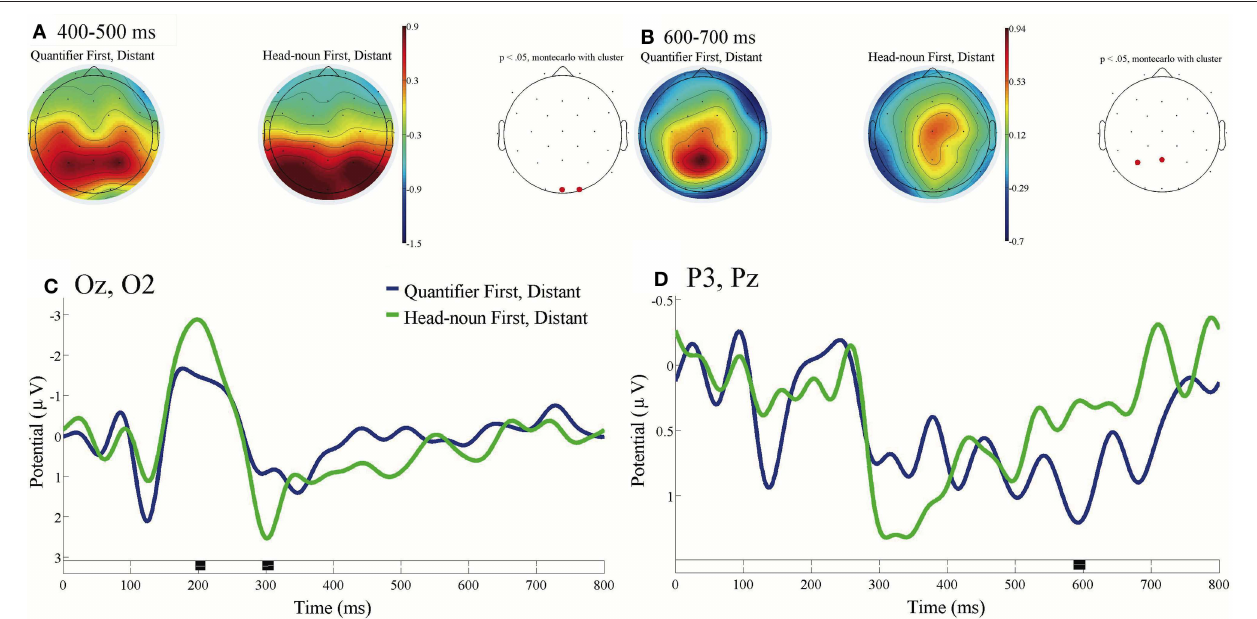
FIGURE 4 | ERPs time-locked to the onsets of the fifth phrases of Distant in Quantifier First and Head-noun First in (A–D) with the baseline from 0 to 100 ms. (A) Mean topographies of the ERPs from 400 to 500 ms and (B) those from 600 to 700 ms for Quantifier First (left) and Head-noun First (right) conditions; the electrode sites at which significant differences were found by using the cluster-based permutation test ( p < 0.05) are depicted in red. (C) Mean ERPs of the two conditions at the occipital electrodes (Oz and O2) and (D) mean ERPs of the two conditions at the (left) parietal electrodes (P3 and Pz). Negativity is plotted upward, and the time windows during which significant differences were found by the cluster-based permutation test are indicated in black on the time axes in (C,D)